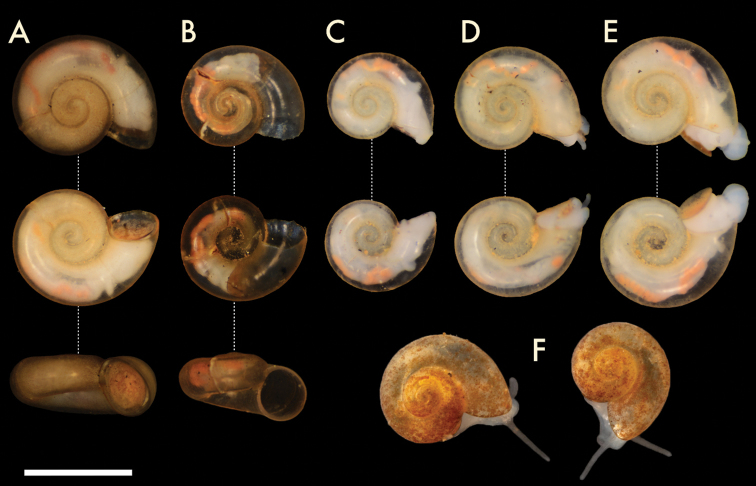
Paratype specimens of Antrorbis
tennesseensis sp. nov. A, B Paratypes ANSP A477042 C–EAntrorbis
cf.
tennesseensis; ANSP A476794 F live specimens of Antrorbis
cf.
tennesseensisfrom Pedigo Cave. Scale bar: 1 mm. Photograph credits: A–E NFS; F MLN.